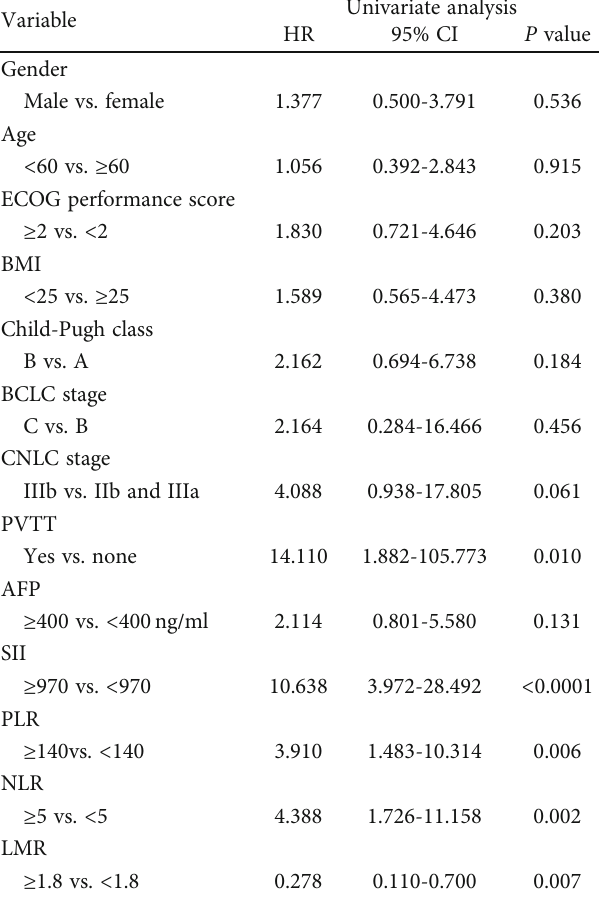
Table 5: Univariate Cox proportional hazards regression models for overall survival.